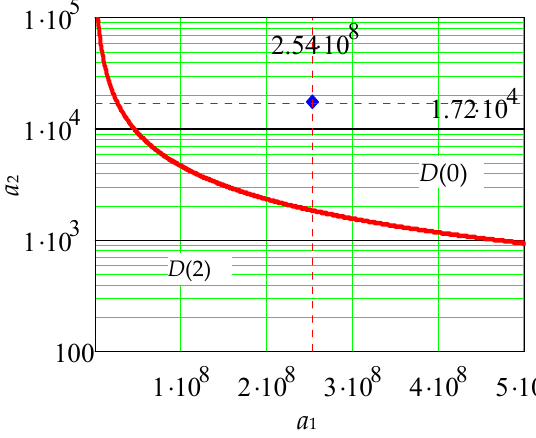
Figure 13. Stability region D (0) of the system in the plane of coefficients a 1 and a 2 .